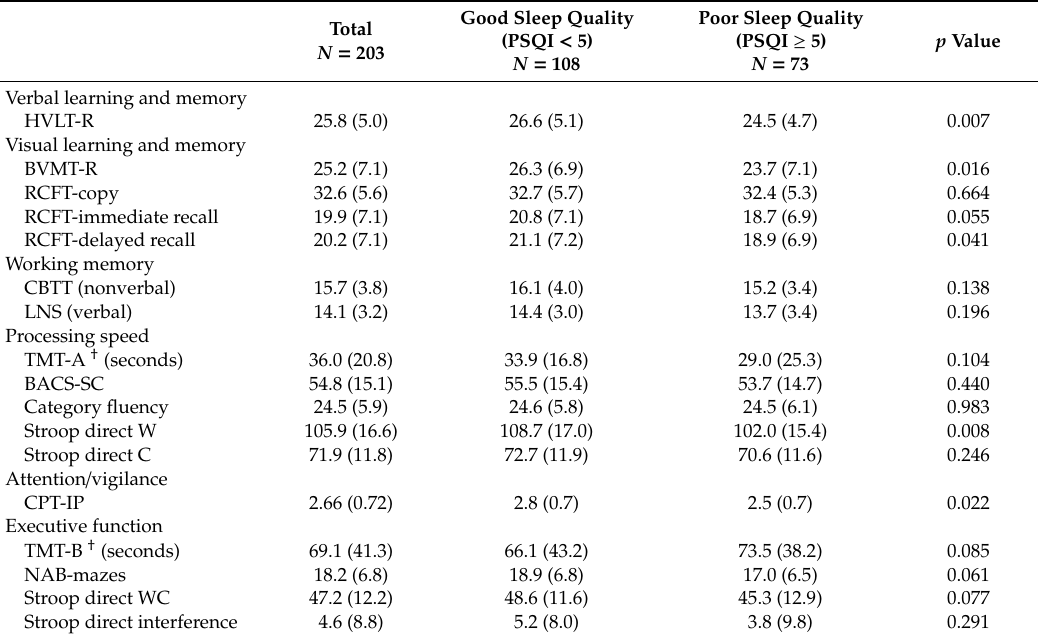
Table 3. Cognitive assessment by sleep quality